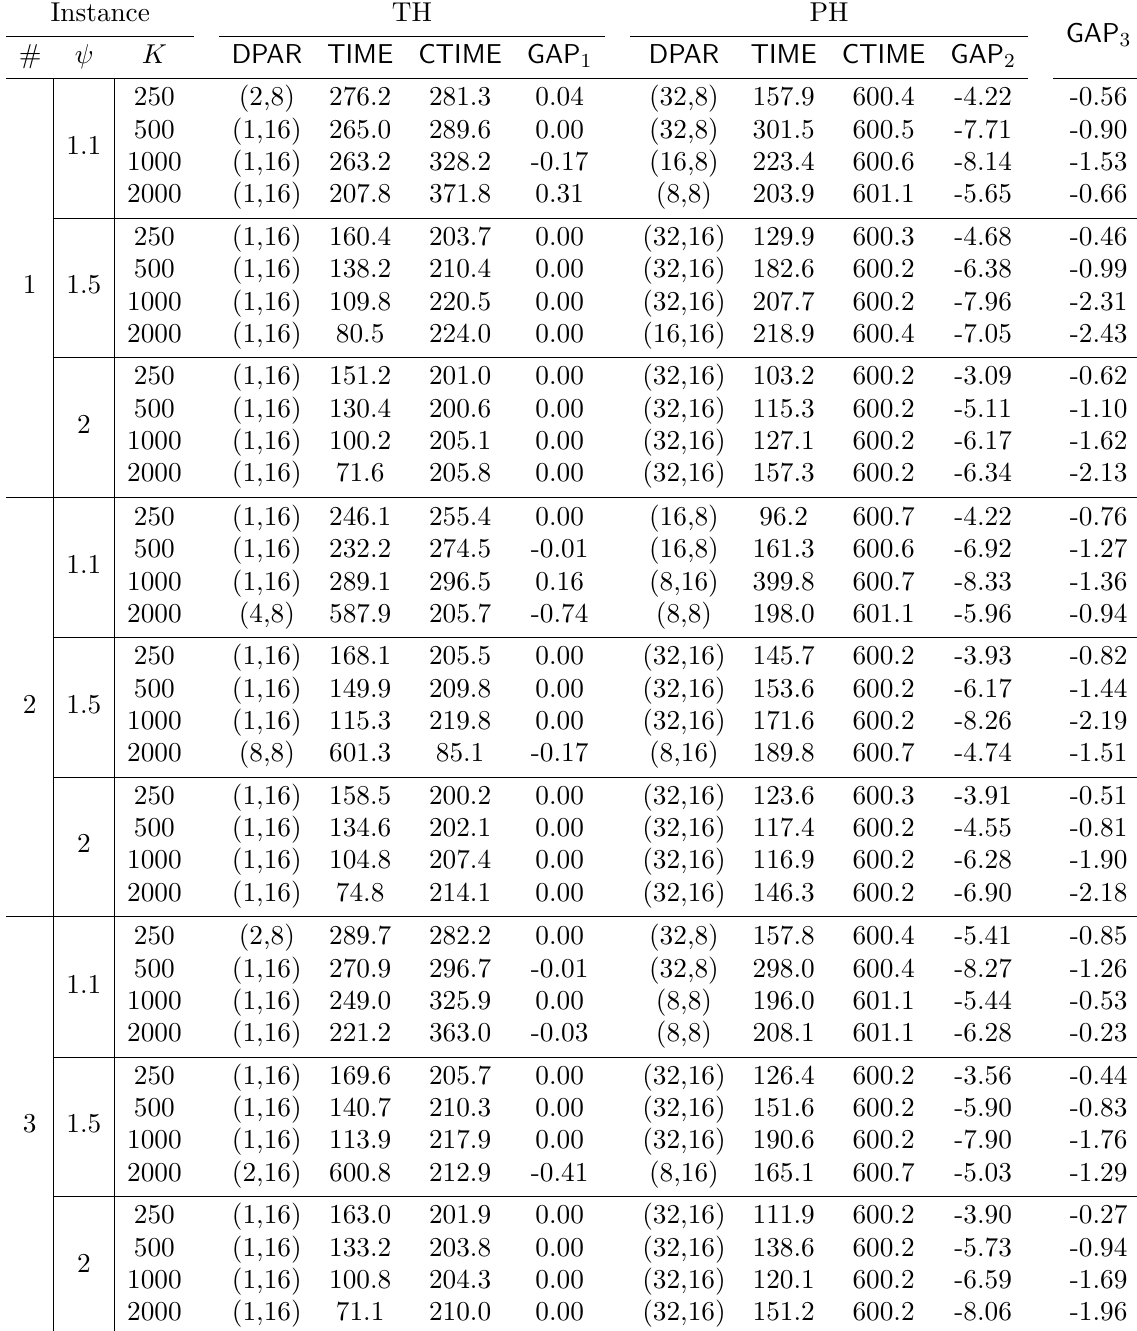
Table 2. Results of the numerical